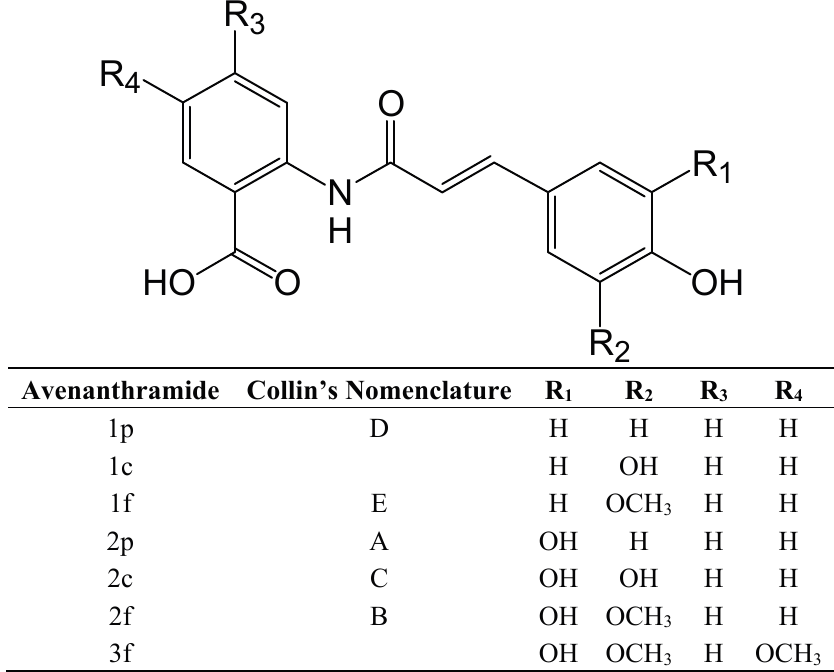
Figure 3. Structures of the derivatives of